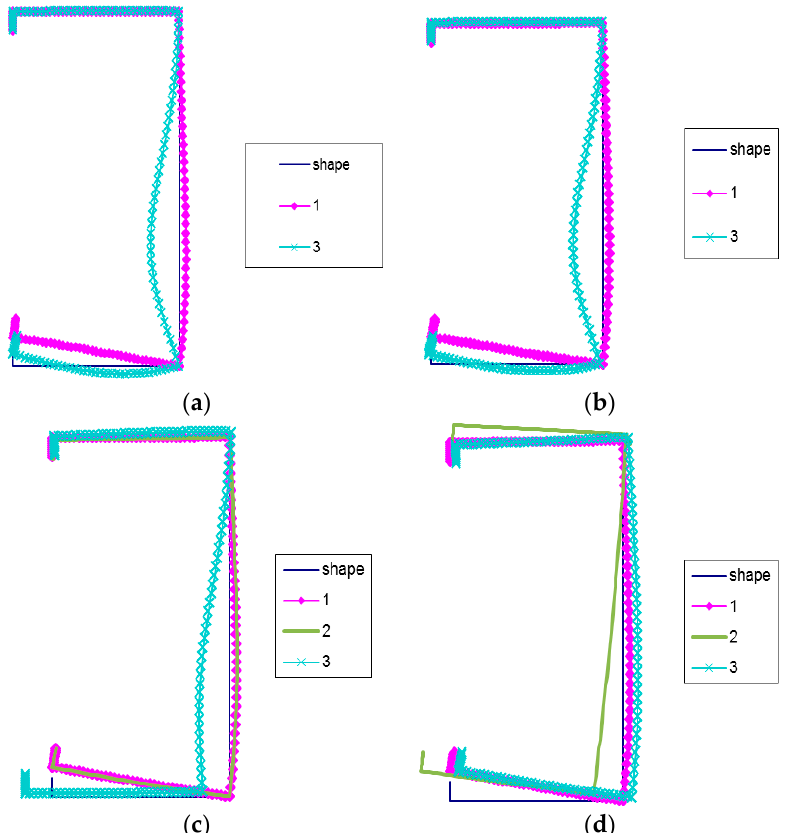
Figure 7. ( a ) Buckling modes for LC-2 beam lengths L = 250 mm, ( b ) Buckling modes for LC-2 beam lengths L = 400 mm, ( c ) Buckling modes for LC-2 beam lengths L = 700 mm, ( d ) Buckling modes for LC-2 beam lengths L = 2000 mm.